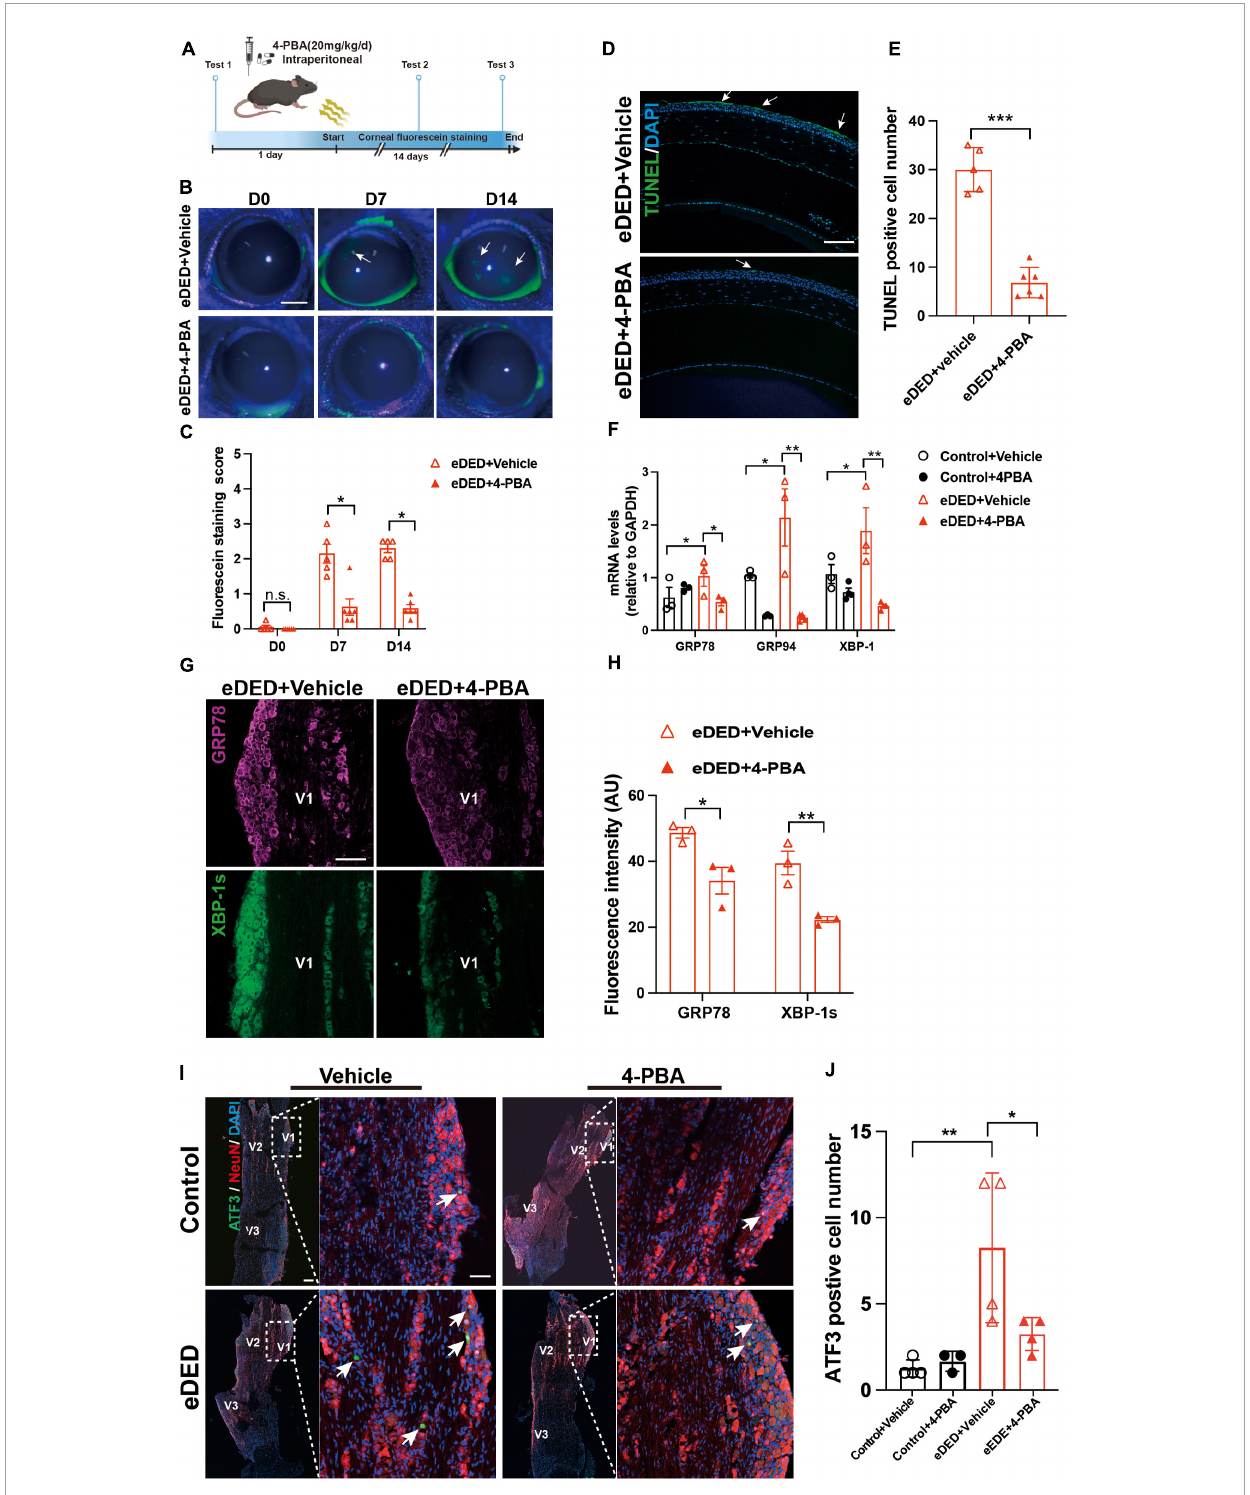
FIGURE5 Decreased TG corneal neuron injury after inhibiting ERS in environmental dry eye disease. (A) Schematic diagram of the 4-PBA treatment procedure in vivo . Mice received 4-PBA (20 mg/kg/day) treatment once a day via intraperitoneal daily before and during CDS; corneal fluorescein testing was performed at three time points (day 0, 7, and 14). (B) Decreased corneal epithelium defective area shown by corneal fluorescein sodium staining (green, arrows) in eDED with 4-PBA treatment mice on day 0, 7, and 14; scale bar: 1 mm. (C) The score of corneal fluorescein sodium staining in eDED with ( n = 5) and without 4-PBA treatment ( n = 6), groups on day 0, 7, and 14. (D) Representative images of corneal epithelium shown decreased apoptotic cells (green, arrows) in eDED with 4-PBA treatment mice via TUNEL assay on day 14; scale bar: 100 µ m. (E) Quantification of TUNEL positive cell number of corneal epithelium in eDED with ( n = 5) and without 4-PBA treatment ( n = 6), groups on day 14. Y-axis represents the number of TUNEL positive cells. Each dot represents mean TUNEL positive cells of three different fields of view (the magnification